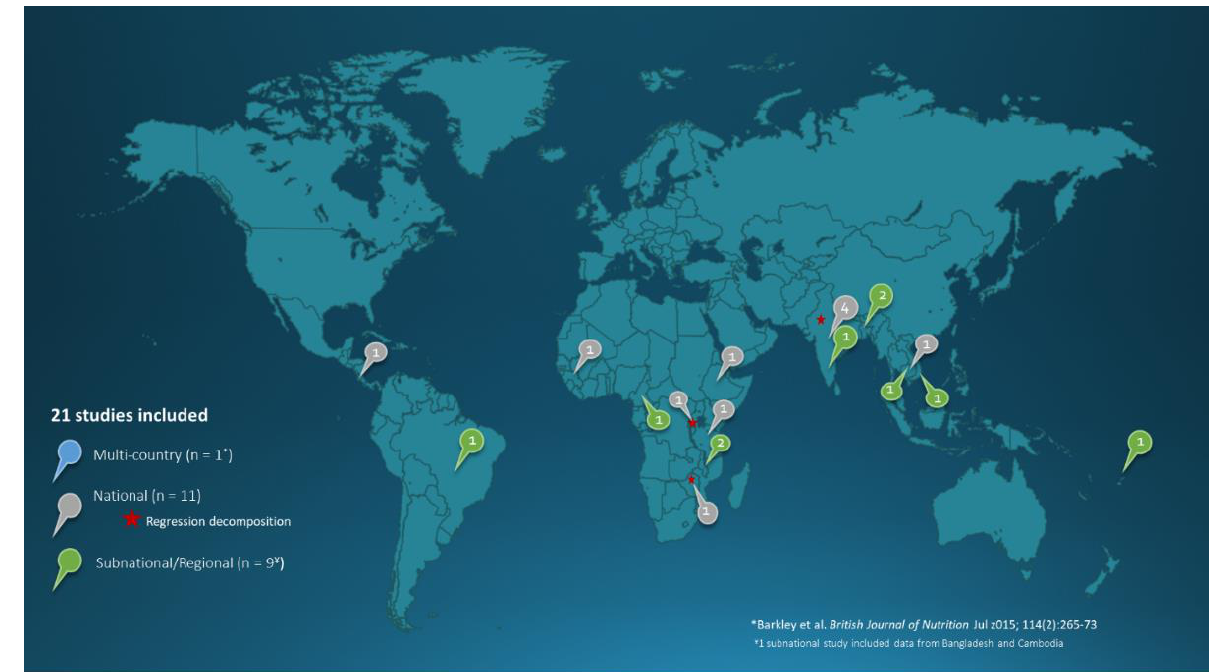
Figure 3. Setting and sample representativeness of included studies.